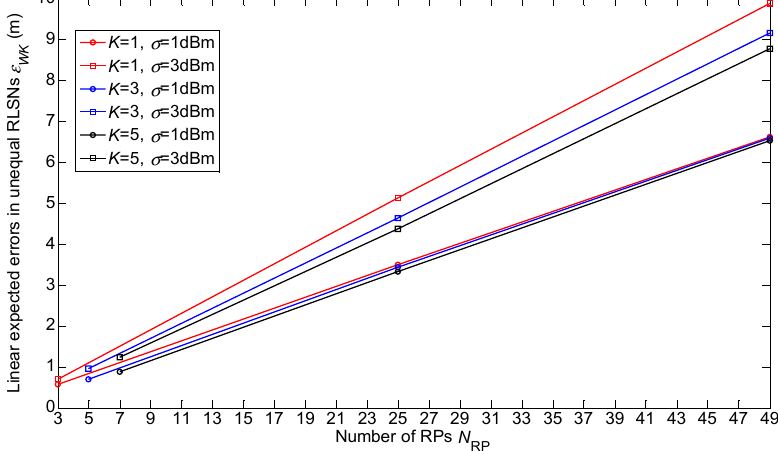
Figure 7. Linear expected errors with variations of K in unequal-weighted RLSNs ( r = 0.5